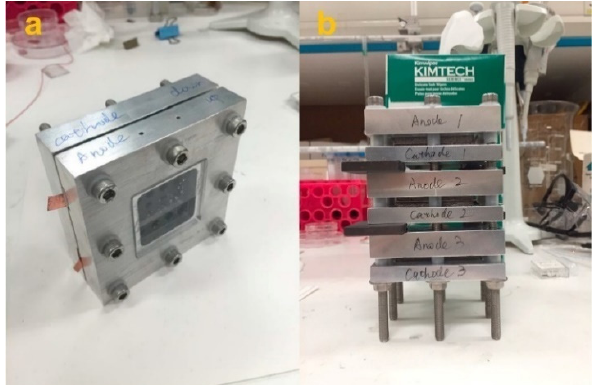
Figure 15. Pictures of ( a ) the single cell PS-DMFC and ( b ) the fuel cell stack assembly using MPC- based BPs. Reproduced from [148] with permission from Elsevier 2019.